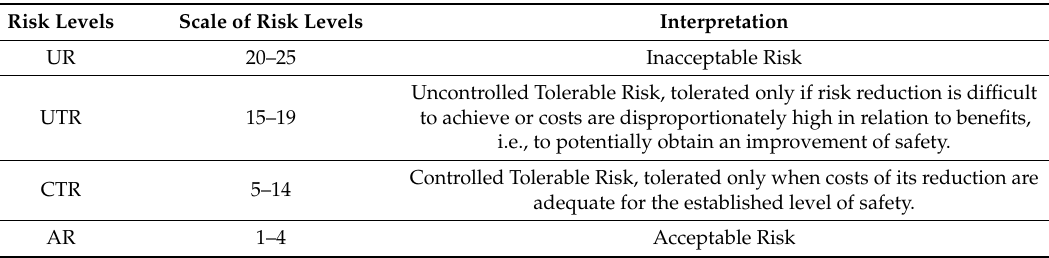
Table 7. Risk levels resulting from ALARP